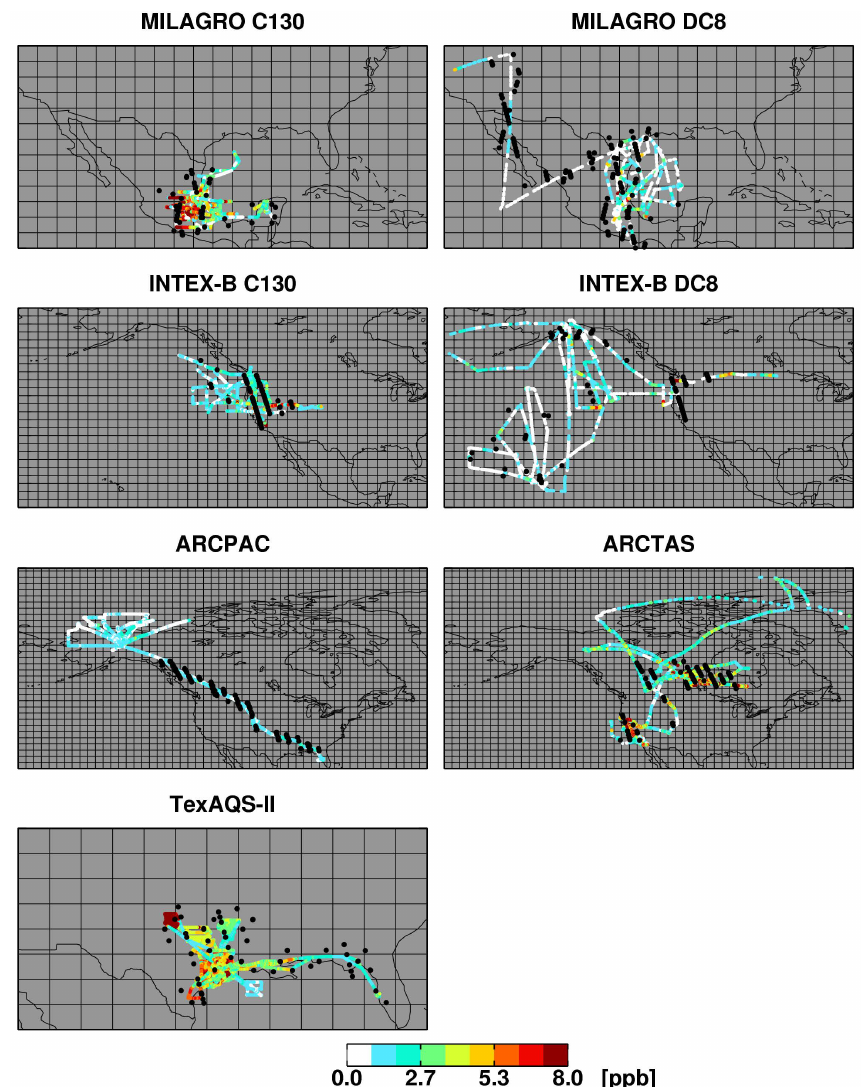
Fig. 2. Maps of aircraft campaign flight tracks and TES observations used for intercomparison. Flight tracks are colored by measured CH 3 OH concentrations and the selected TES observations are shown as black circles. The grid lines indicate the GEOS-Chem grid box